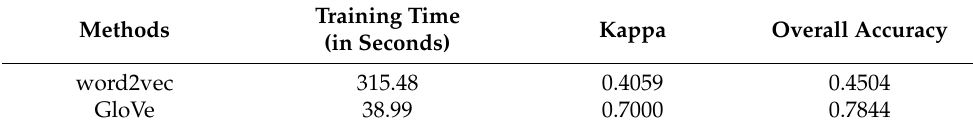
Table 8. Evaluation index of urban function